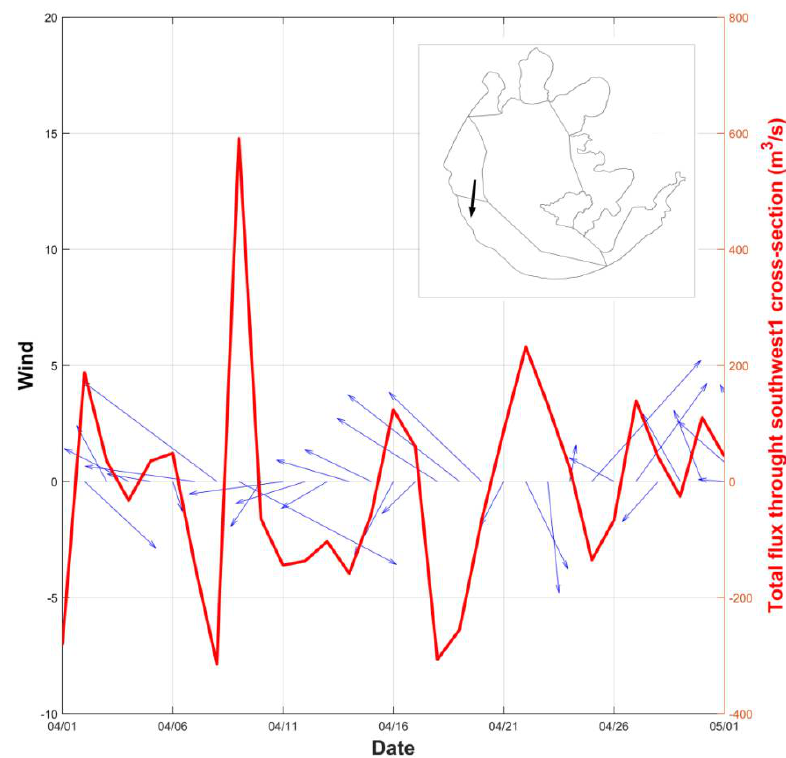
Figure 12. Total discharges and corresponding wind vector of southwest1 cross-section in April 2008. The blue vector represents the wind record and the red line represents the total flux through southwest1 cross-section. The length of the blue wind vector is the magnitude of wind speed. The position and the arrow representing the positive flux are illustrated in the upper right subplot.